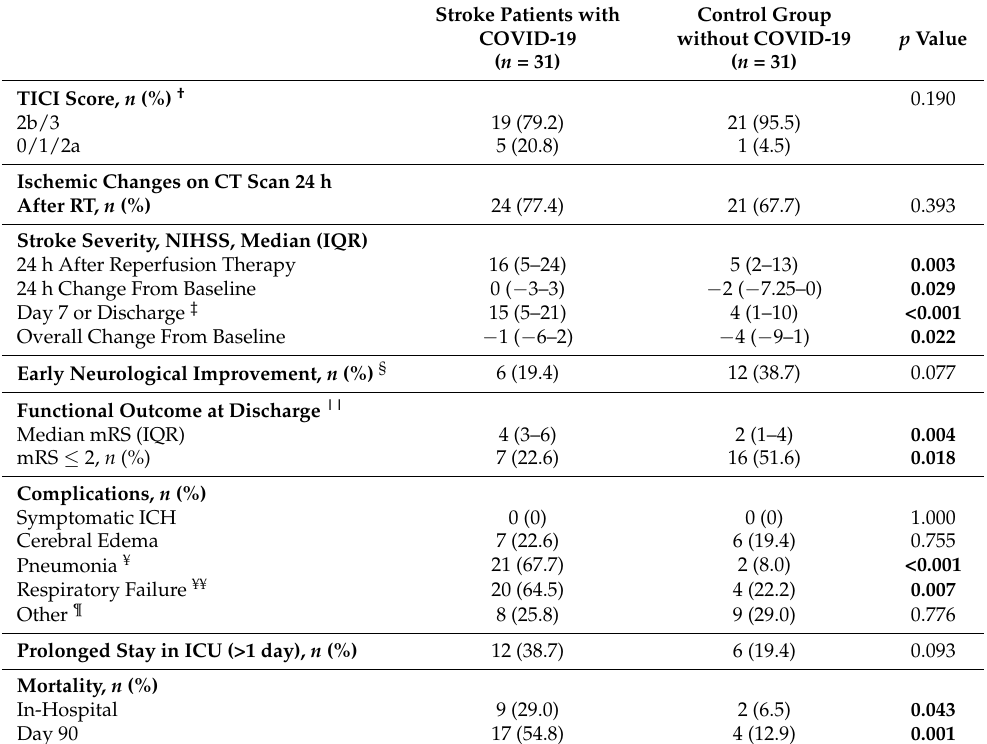
Table 3. Patient treatment outcomes and complications.